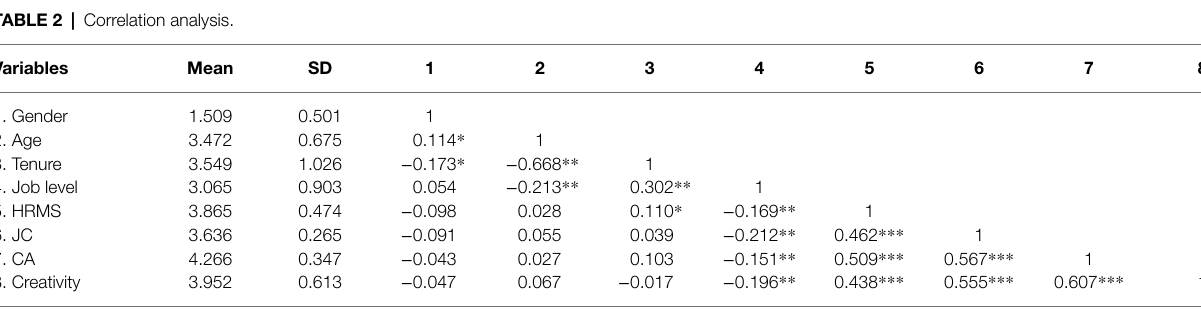
TABLE 2 | Correlation analysis. Variables